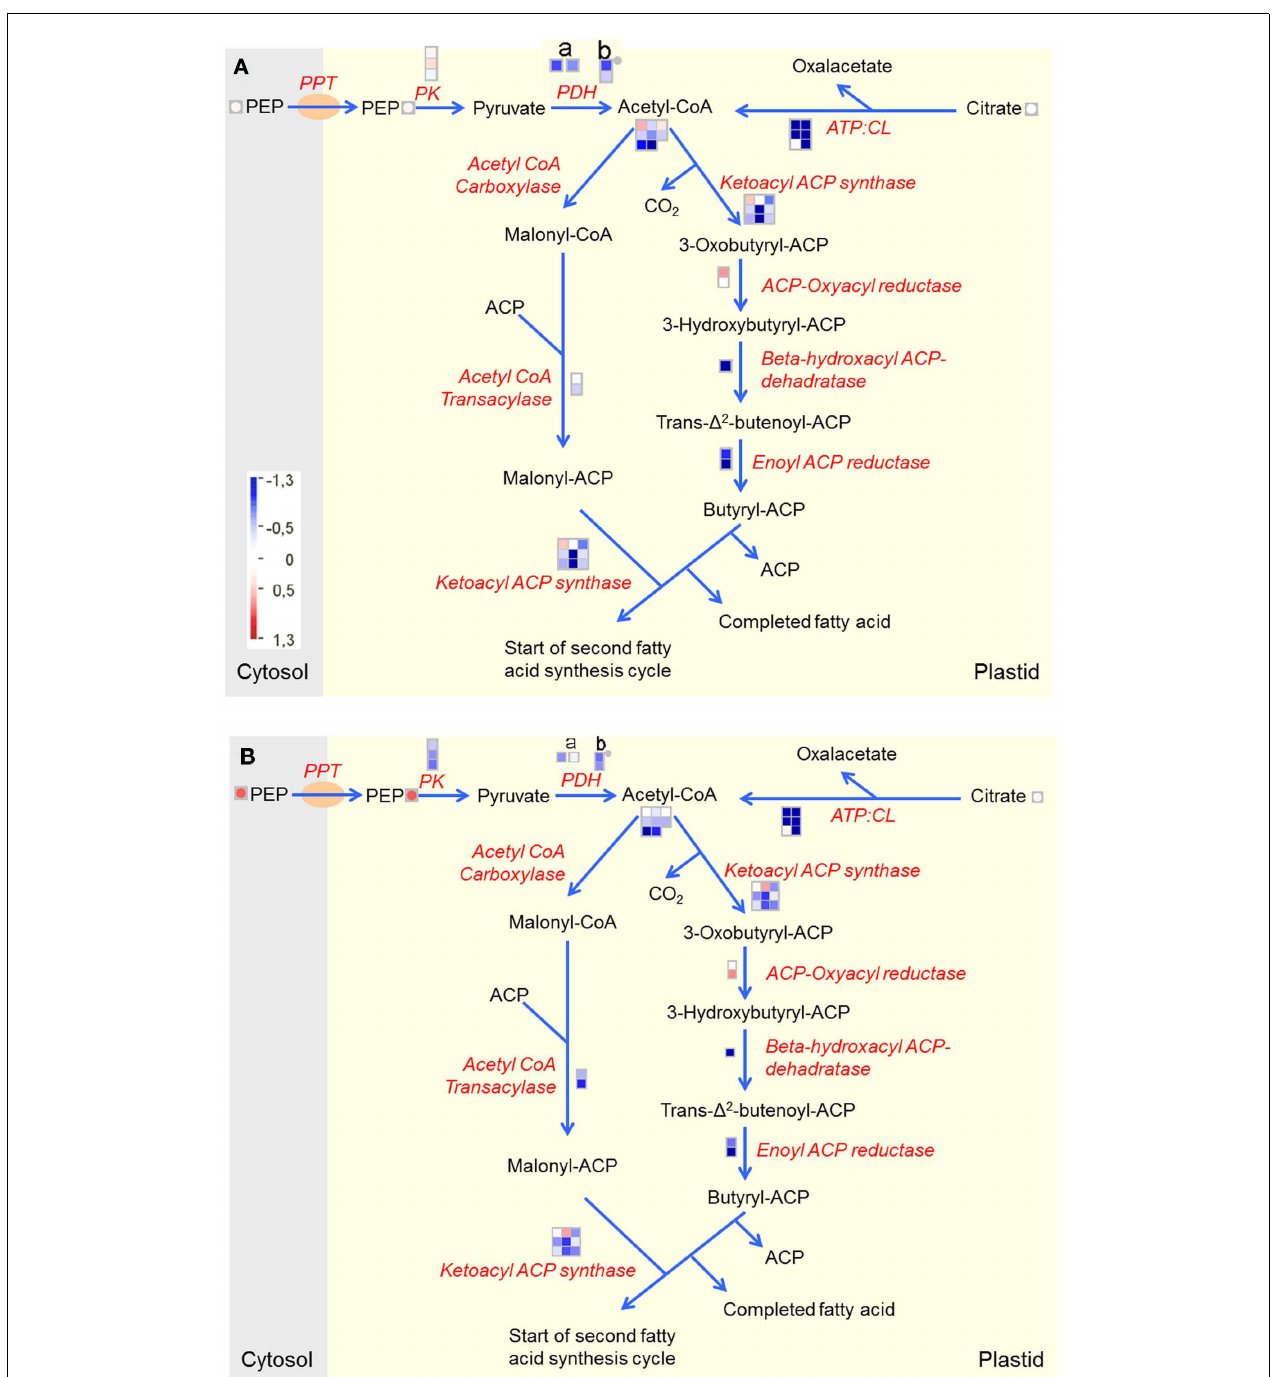
FIGURE 5 | Fatty acid metabolism from imported PEP and citrate in (A) U-IN-1 and (B) U-IN-2. Different subunits of the pyruvate dehydrogenase complex: (a) E2. (b) E3.